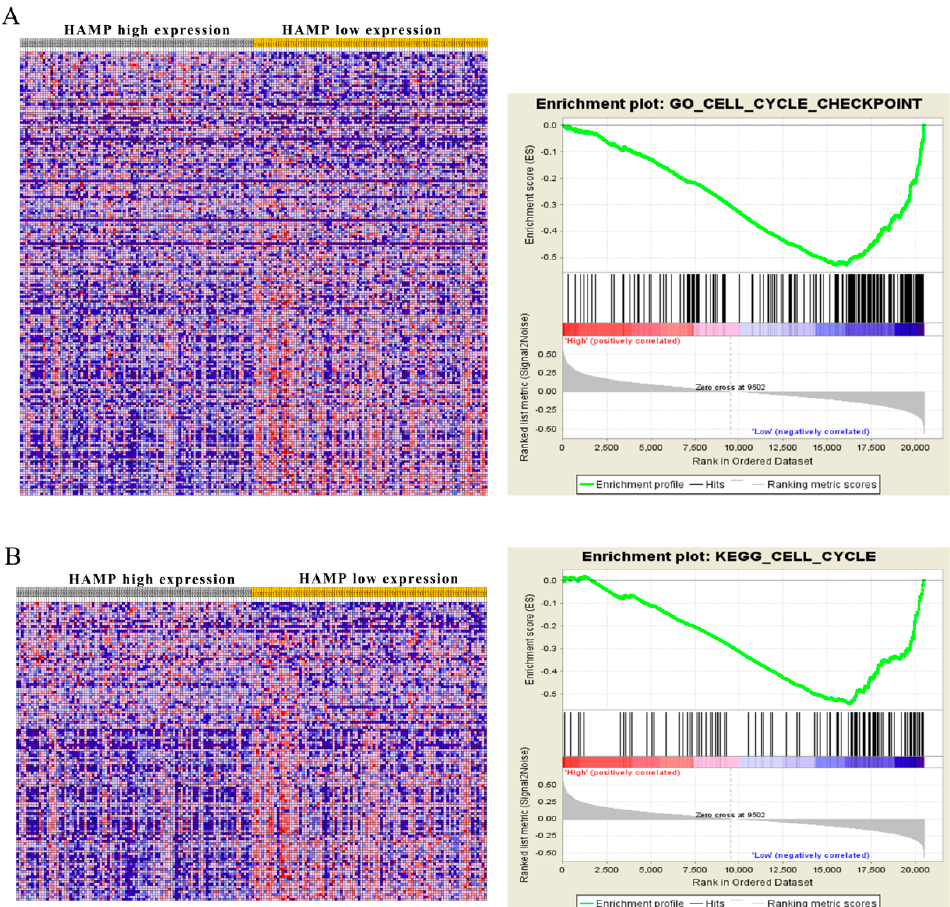
Figure 5. Gene set enrichment analysis (GSEA) based on HAMP expression in HCC patients. To identify pathways linked to HAMP expression in The Cancer Genome Atlas (TCGA) samples, we compared gene expression in those with low HAMP expression (blue) and high HAMP expression (red). Visualizations were produced using Cytoscape and Enrichment map (1% FDR, p < 0.005). Each node is representative of a set of enriched genes, with annotations being ascribed based on how similar the sets are to one another. A network of nodes was used to map the enrichment results, with the size of nodes being directly correlated with the gene number in that particular gene set. The number of genes shared between two given gene sets determined the thickness of the green line connecting them. The final map was generated via removal of any general or noninformative smaller networks in order to simplify the final diagram. ( A ) Go enrichment plot showed HAMP downregulation is related to cell cycle checkpoint. ( B ) KEGG enrichment plot showed HAMP downregulation is related to the cell cycle.